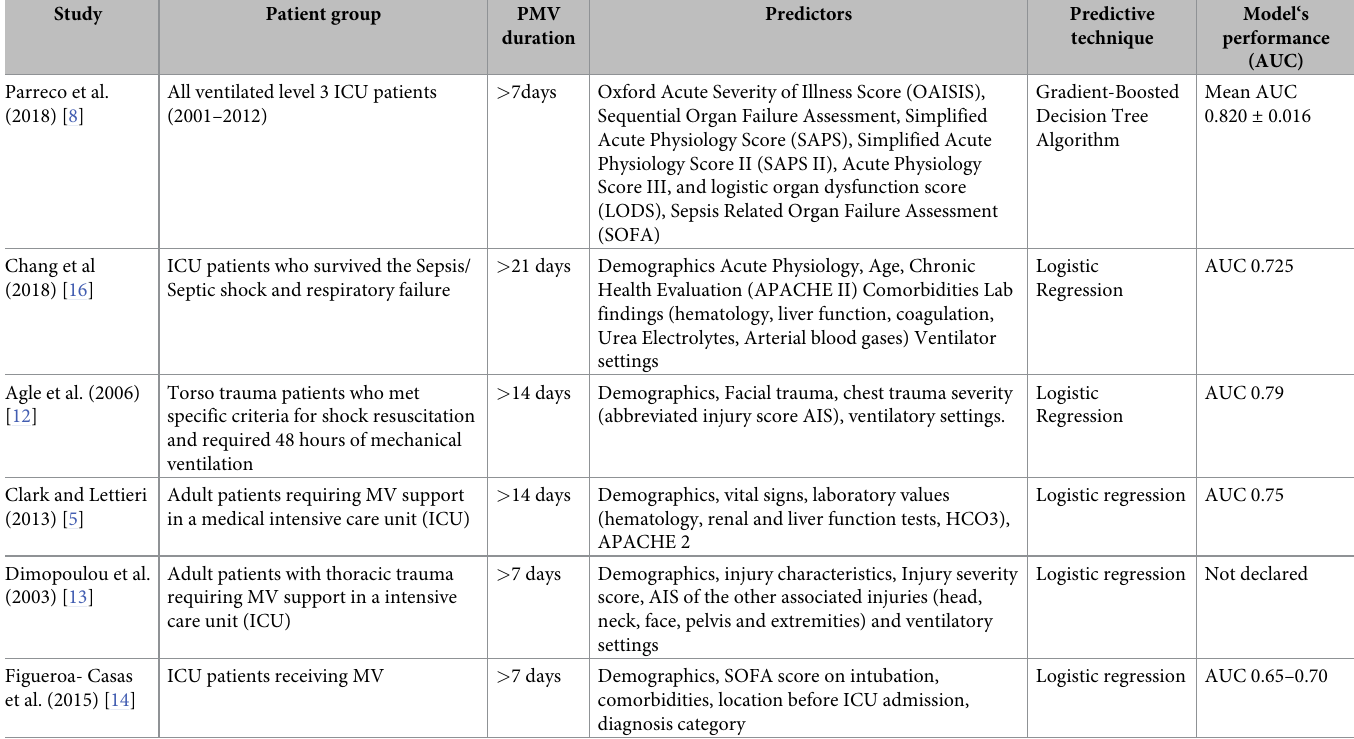
Table 1. Examples of past literature on predicting